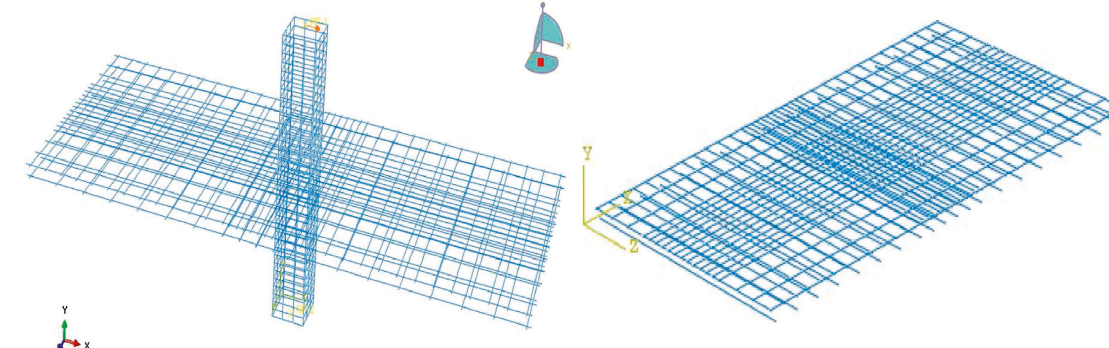
Figure 5: Detail reinforcement for the specimens.